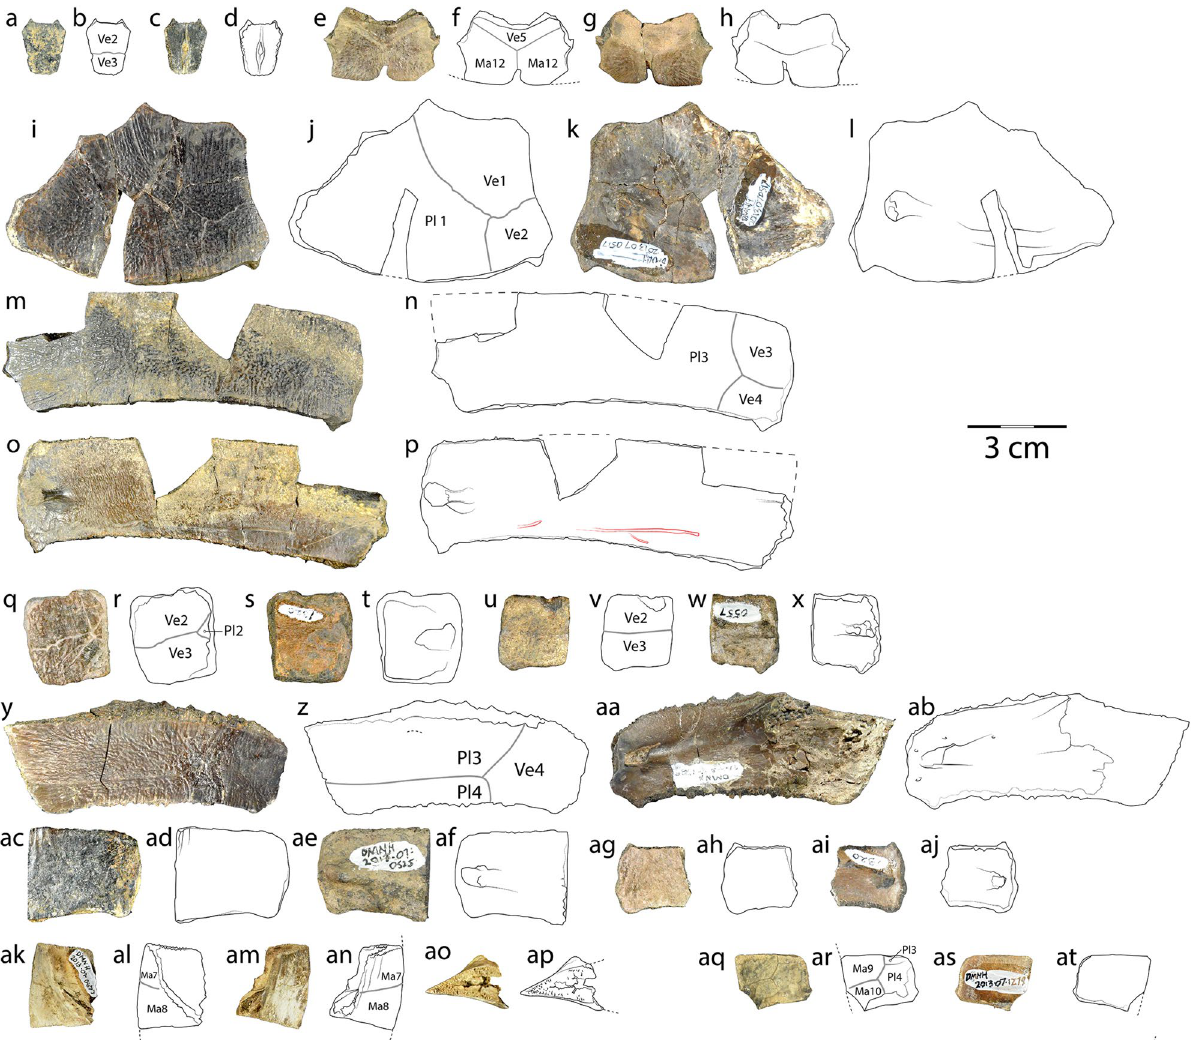
drawing, ( c ) ventral photograph, and ( d ) ventral drawing of DMNH 2013-07-0683, neural 3. ( e ) Dorsal photograph, ( f ) dorsal drawing, ( g ) ventral photograph, and ( h ) ventral drawing of DMNH 2013-07-1998, pygal. ( i ) Dorsal photograph, ( j ) dorsal drawing, ( k ) ventral photograph, and ( l ) ventral drawing of DMNH 2013-07- 0517, left costal 1. ( m ) Dorsal photograph, ( n ) dorsal drawing, ( o ) ventral photograph, and ( p ) ventral drawing of DMNH 2013-07-1999, left costal 5. ( q ) Dorsal photograph, ( r ) dorsal drawing, ( s ) ventral photograph, and ( t ) ventral drawing of DMNH 2013-07-1320, partial cf. right costal 3. ( u ) Dorsal photograph, ( v ) dorsal drawing, ( w ) ventral photograph, and ( x ) ventral drawing of DMNH 2013-07-0557, partial cf. right costal 3. ( y ) Dorsal photograph, ( z ) dorsal drawing, ( aa ) ventral photograph, and ( ab ) ventral drawing of DMNH 2013-07-1405, left costal 6. ( ac ) Dorsal photograph, ( ad ) dorsal drawing, ( ae ) ventral photograph, and ( af ) ventral drawing of DMNH 2013-07-0525, partial cf. left costal 4. ( ag ) Dorsal photograph, ( ah ) dorsal drawing, ( ai ) ventral photograph, and ( aj ) ventral drawing of DMNH 2013-07-1320, partial cf. right costal 4. ( ak ) Dorsal photograph, ( al ) dorsal drawing, ( am ) ventral photograph, ( an ) ventral drawing, ( ao ) posterior photograph, and ( ap ) posterior drawing of DMNH 2013-07-0673, right peripheral 7. ( aq ) Dorsal photograph, ( ar ) dorsal drawing, ( as ) ventral photograph, and ( at ) ventral drawing of DMNH 2013-07-1279, left peripheral 9. All parts of figure to same scale. Figure created with Adobe Creative Cloud (Adobe